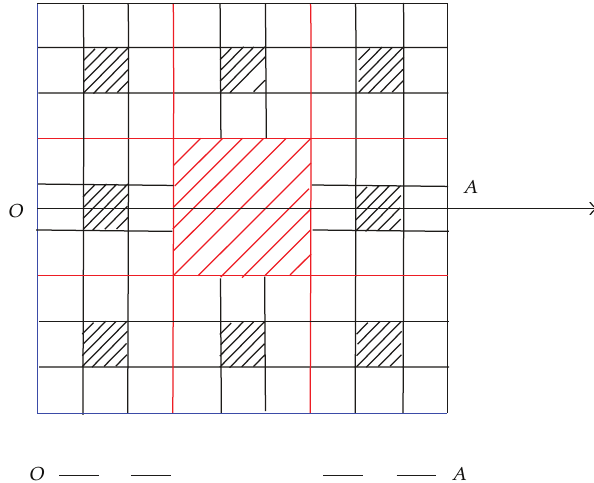
Figure 8: A schematic diagram of distance between O and A (cid:5) i.e., the fractal coordinate of A (cid:6) in a fractal space, and D (cid:7) ln2 / ln3, while the fractional dimensions for the plane are ln8 /